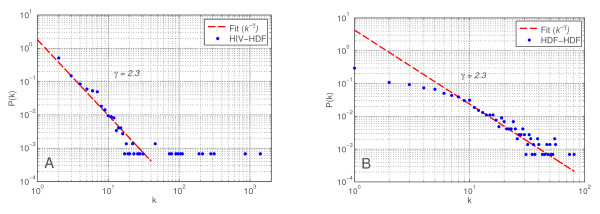
Degree distributions of HDFs on a log-log scale. P(k) is the fraction of nodes with degree k. A: Only connections of HDFs to HIV proteins. B: Only HDF-HDF connections. Both distributions were fitted with a power law (P(k) = k-γ) with A: γ = 2.3, and B: γ = 2.3, showing the scale-free nature of both networks.